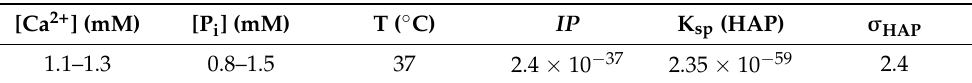
Table 2. Physicochemical characteristics of human plasma. The supersaturation can be defined as: 1 ) ν , where K sp is the solubility product, IP the ionic product, which can be σ = ln ( IP K sp